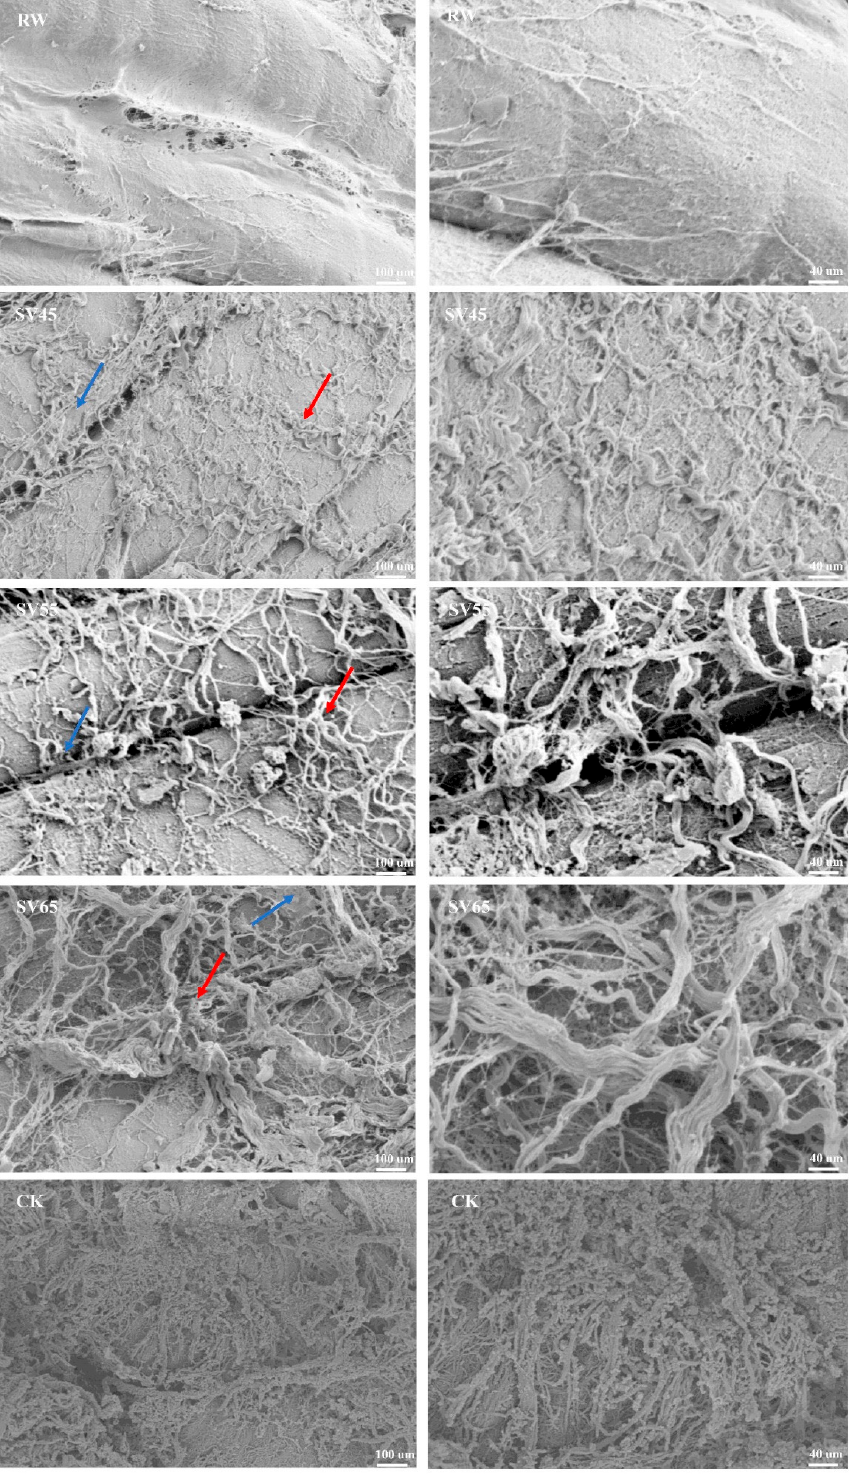
Figure 4. SEM images of intramuscular connective tissues from RW, SV sample and CK.